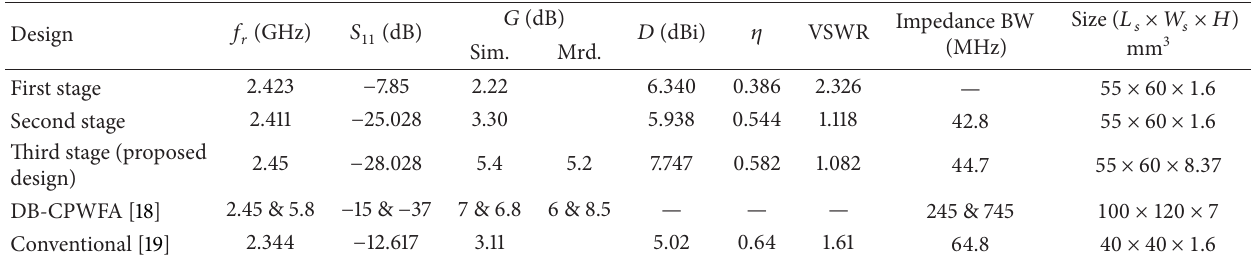
Table 1: Comparison of the antennas’ parameters.